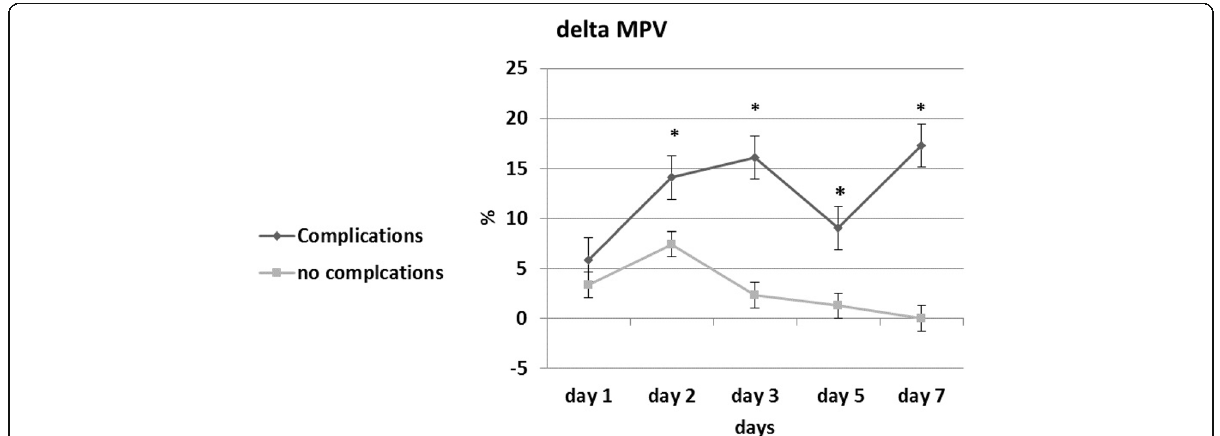
Fig. 6 Percentage changes in MPV (Delta MPV) among ICU complicated versus non-complicated patients during the 1st week of ICU stay. Data presented as means, and error bars represent standard deviation. The asterisk (*) indicates significant difference of Delta MPV between complicated and non-complicated